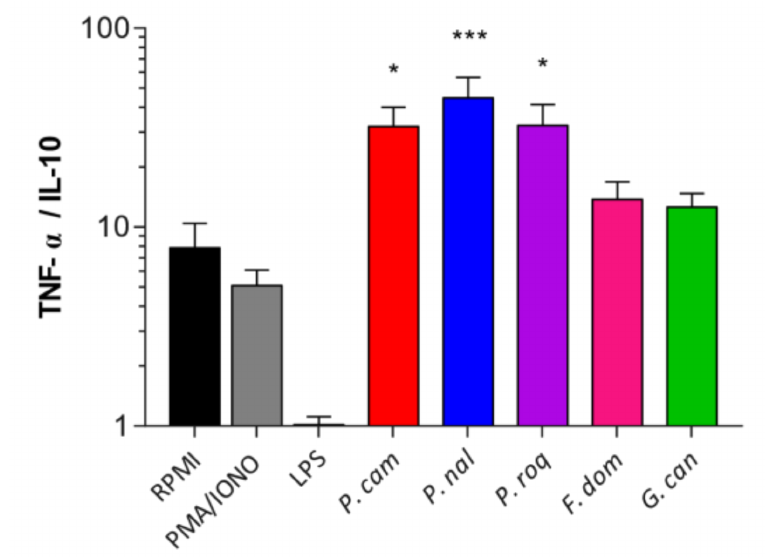
Figure 3. Human immune cells differentially recognize fungal spores. Ratio of TNF- α /IL-10 produc- tion of the culture supernatants of peripheral blood mononuclear cells (PBMCs) co-incubated with Penicillium camemberti ( P. cam ), P. nalgiovense ( P. nal ), P. roqueforti ( P. roq ), Fusarium domesticum ( F. dom ), or Geotrichum candidum ( G. can ) for 24 h at MOI5. For statistical comparisons, (*) indicates versus RPMI. * p < 0.05, *** p <